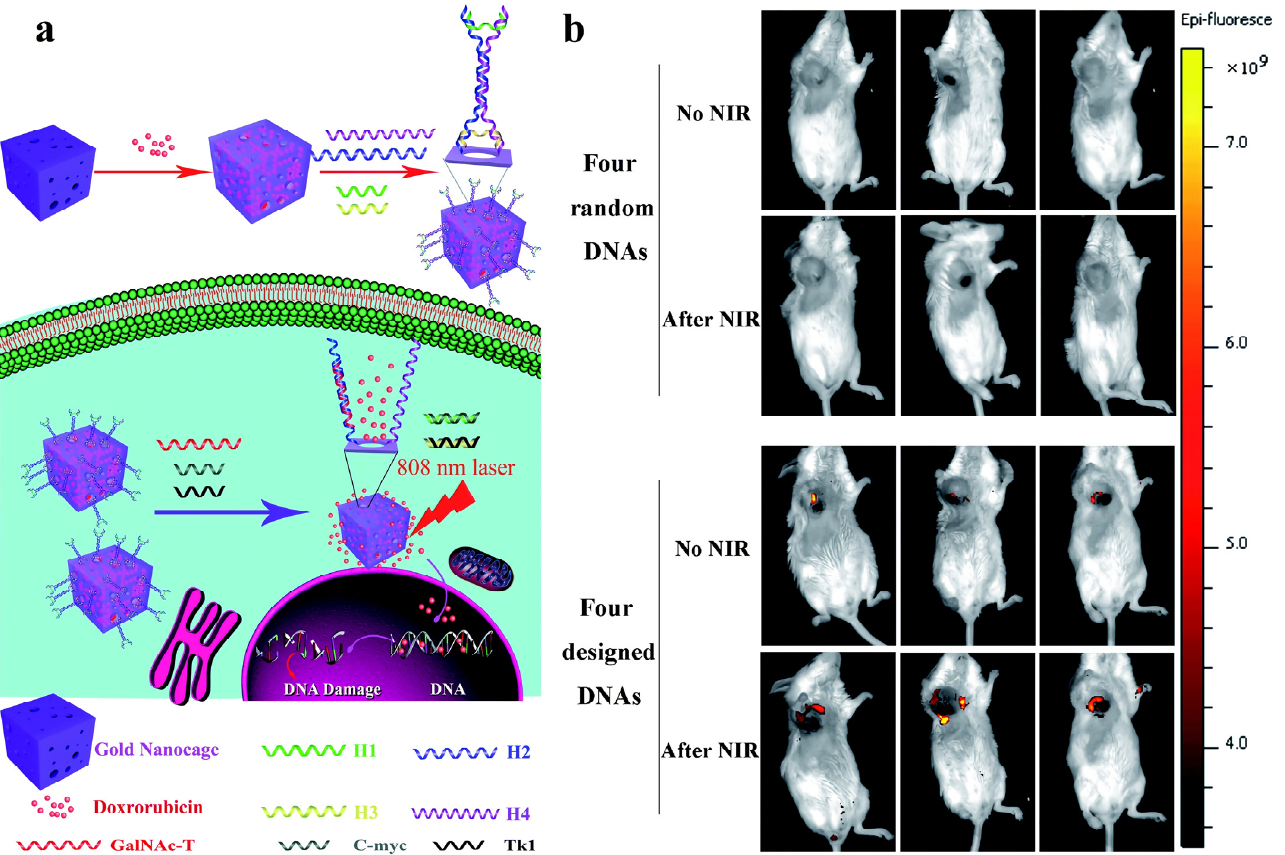
Figure 12. ( a ) Schematic illustration of the mRNA- and light-responsive AuNCs for controlled drug release; ( b ) in vivo fluorescence images of tumor-bearing mice injected with ICG-loaded AuNCs. Reprinted/adapted with permission from Ref. [101]. Copyright 2021, The Royal Society of Chemistry.